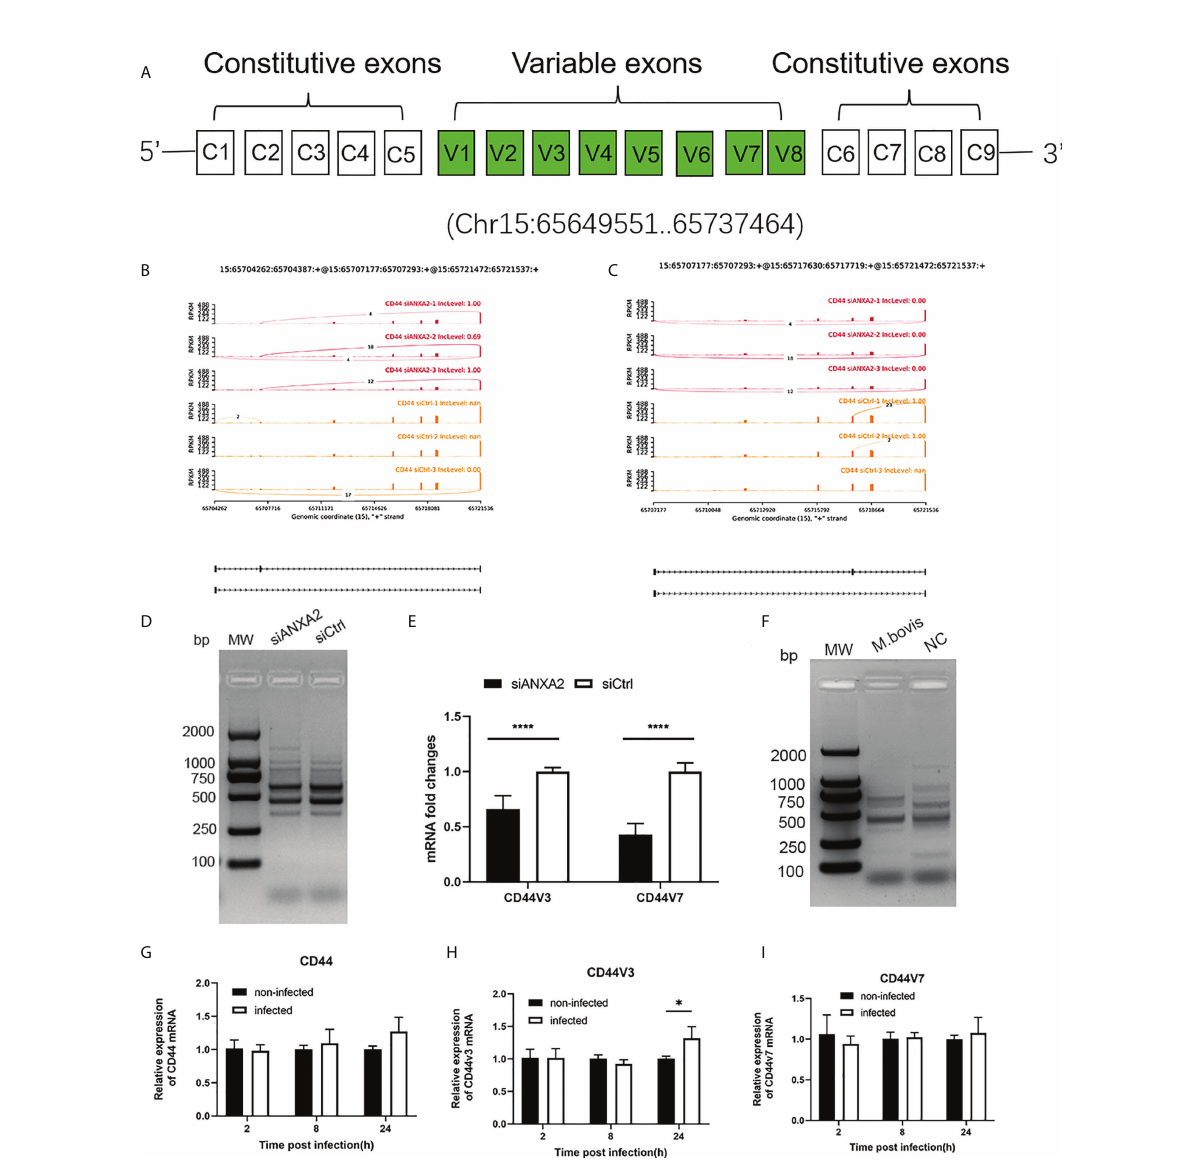
FIGURE 10 ANXA2 knockdown resulted in alternative splicing of CD44 after M. bovis infection. (A) . CD44 standard and variant exons are depicted schematically, with invariant exons 1-5 and the last fi ve exons and variant exons v1-v7. B , C . Sashimi plots depicting the region tested for the presence of alternative splicing isoforms due to the skipped exons in CD44 gene. Genomic coordinates, chromosome number, strand and exon number are indicated below. Inclusion level (IncLevel) represents the ratio of the expression of exon inclusion isoform in the total exon inclusion and exon skipping isoforms, which could be directly show the expression differences of variable splicing events in the siANXA2 and siCtrl group. D The inclusion of CD44 exons in alternative splicing in M. bovis infected-ANXA2 knockdown cells was validated using RT-PCR. The forward primer was designed on exon C5 of CD44 mRNA, while the reverse primer on exon C6. E The differential expression of CD44 v3 and v7 in infected EBL cells was quanti fi ed using qPCR between M. bovis infected-siANXA2 transfected and control EBL cells ( M. bovis infected-siCtrl transfected EBL cells. The qPCR results are the mean of three biological replicates. **** p < 0.0001. F Semi-quantitative RT-PCR of CD44 isoforms after M. bovis infection in EBL cells. G - I Quantitative PCR analysis of changes in CD44, CD44V3, CD44V7 after M. bovis infected at different times. Data represent means ± SD. * p